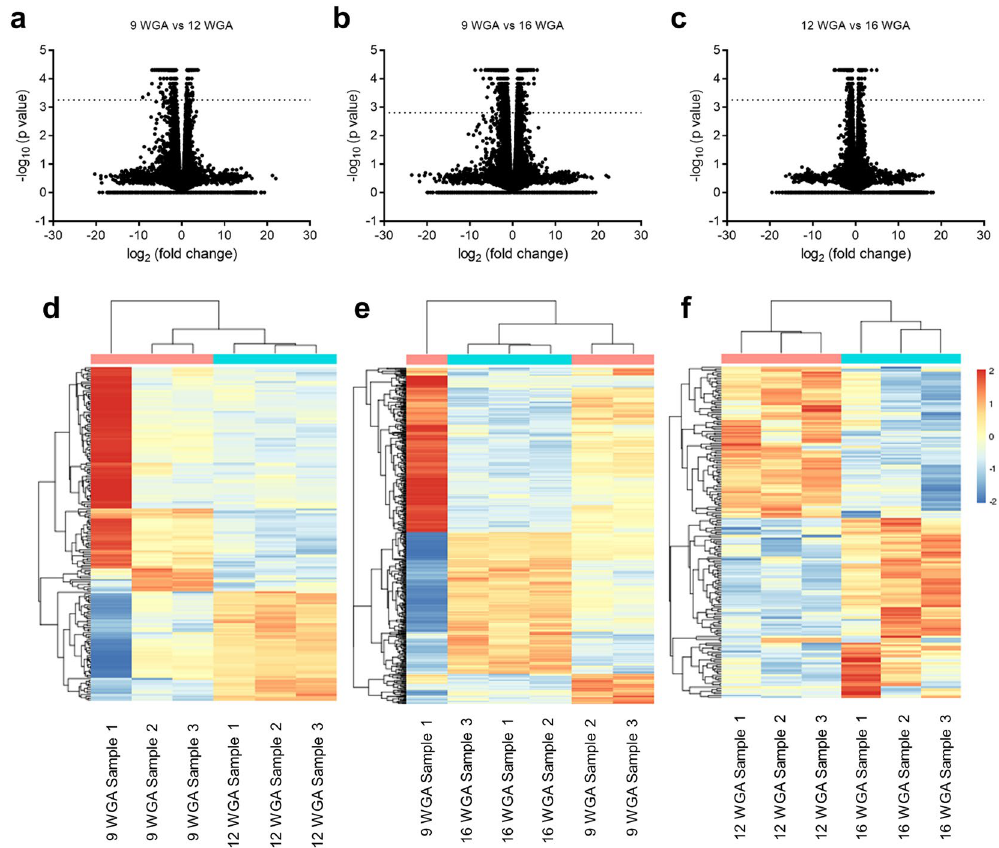
Figure 1. Differential gene expression during development. Volcano plots (log2 fold change against -log10 of the P value) of the ~57,000 transcripts comparing ( a ) 9 and 12 weeks gestation age (WGA), ( b ) 9 and 16 WGA and ( c ) 12 and 16 WGA. Differential expression was considered significant for genes above the line, representing the Bonferroni correct significance cut-off. ( d – f ) Heat map representation of gene expression (upregulation in red and down regulation in blue) of the individual samples comparing 9 and 12 WGA ( d ), 9 and 16 WGA ( e ) and 12 and 16 WGA ( f ). The denograms indicate the clustering of samples and time points (top) and genes